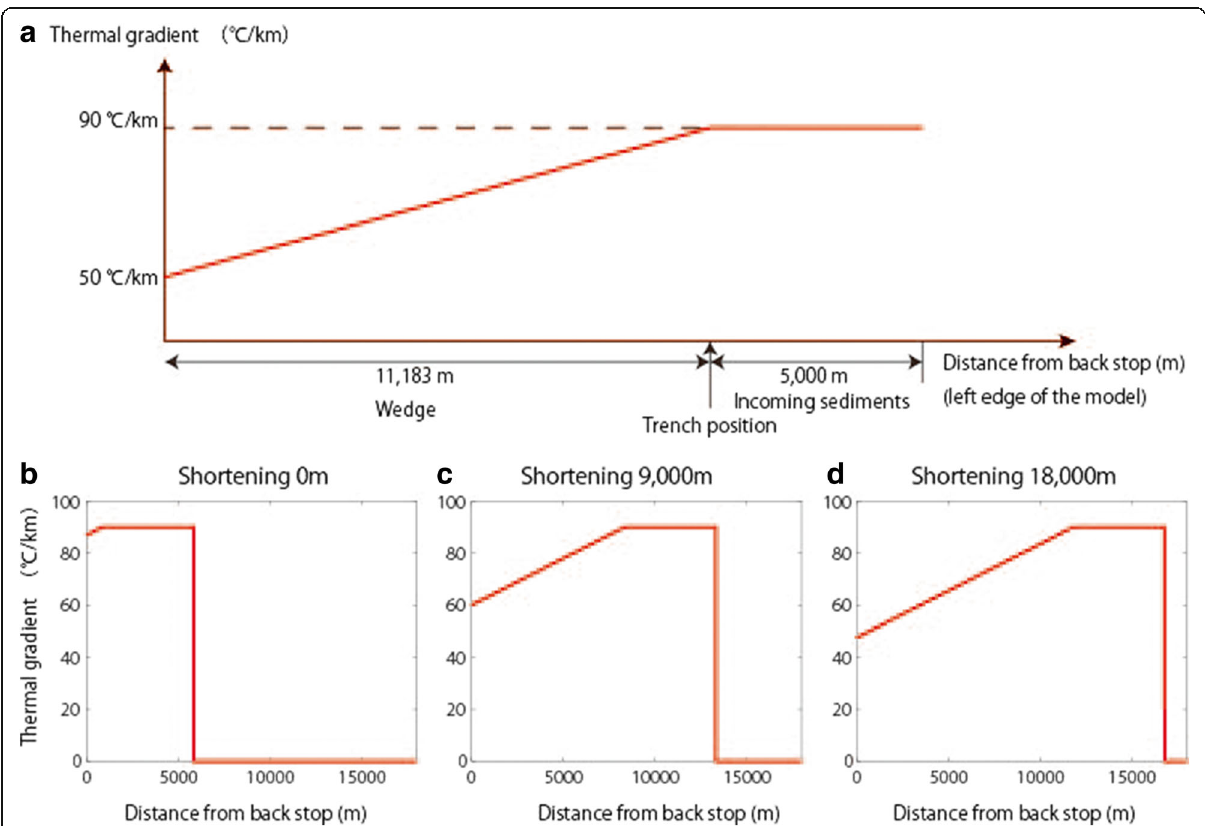
Fig. 2 The thermal gradient models for the calculation of the temperature of each particle. The horizontal axis depicts the distance from the left side wall (c.a., moving backstop), whereas the vertical axis depicts the thermal gradient. The thermal gradient is linearly interpolated from the input sediments at 90°C/km to the landward end at 50°C/km in the final condition. The final thermal gradient model after 22,500m of shortening ( a ). The thermal gradient model for different amounts of shortening, i.e., for 0m (c.a., initial condition) ( b ), 9000m ( c ), and 18,000m ( d